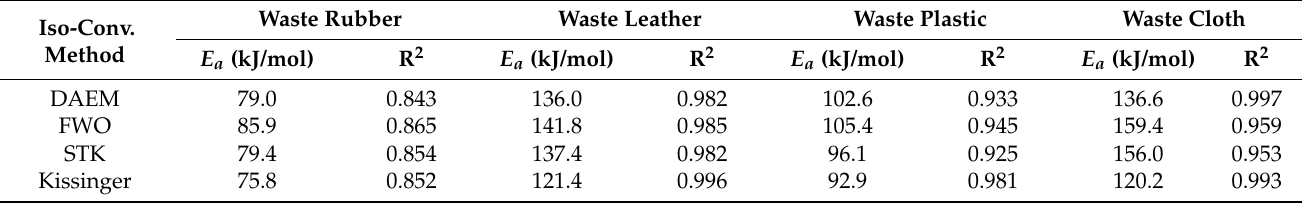
Table 3. Average values of activation energy determined by DEAM, FWO, STK and KAS methods for each devolatilization event derived from combustion process of the polymeric